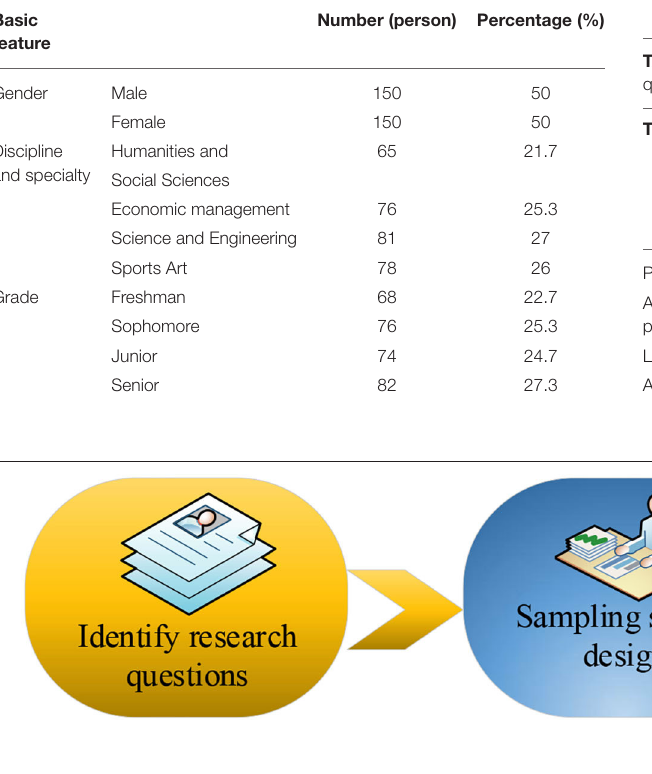
Table 3 indicates that after testing the correlation between students of different genders and their values and risk attitudes toward entrepreneurship, it is found that the correlations between the values and risk attitudes of students of different genders toward entrepreneurship are 0.712, 0.5856, and 0.5961, respectively, which prove that there is a positive correlation between them. The correlations between students with different entrepreneurial values and gender and entrepreneurial risk outlook are 0.5269, 0.5697, and 0.6245, respectively, indicating that they are also positively correlated with each other. For students with different entrepreneurial risk outlooks, the correlations with gender and entrepreneurial values are 0.634, 0.6893, and 0.6358, respectively, which also indicates that they are also